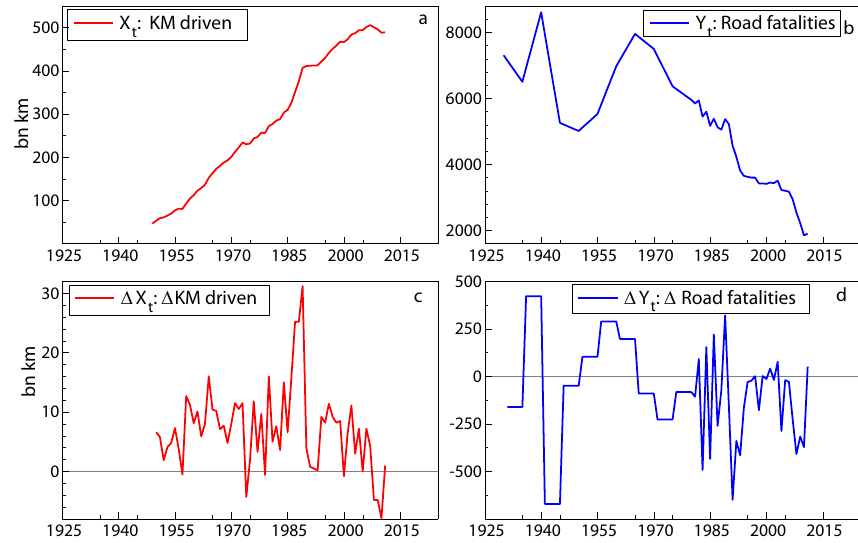
Fig. 1. Vehicle kilometers driven and road fatalities p.a. in the UK: in levels (a, b) and first differences (c, d)